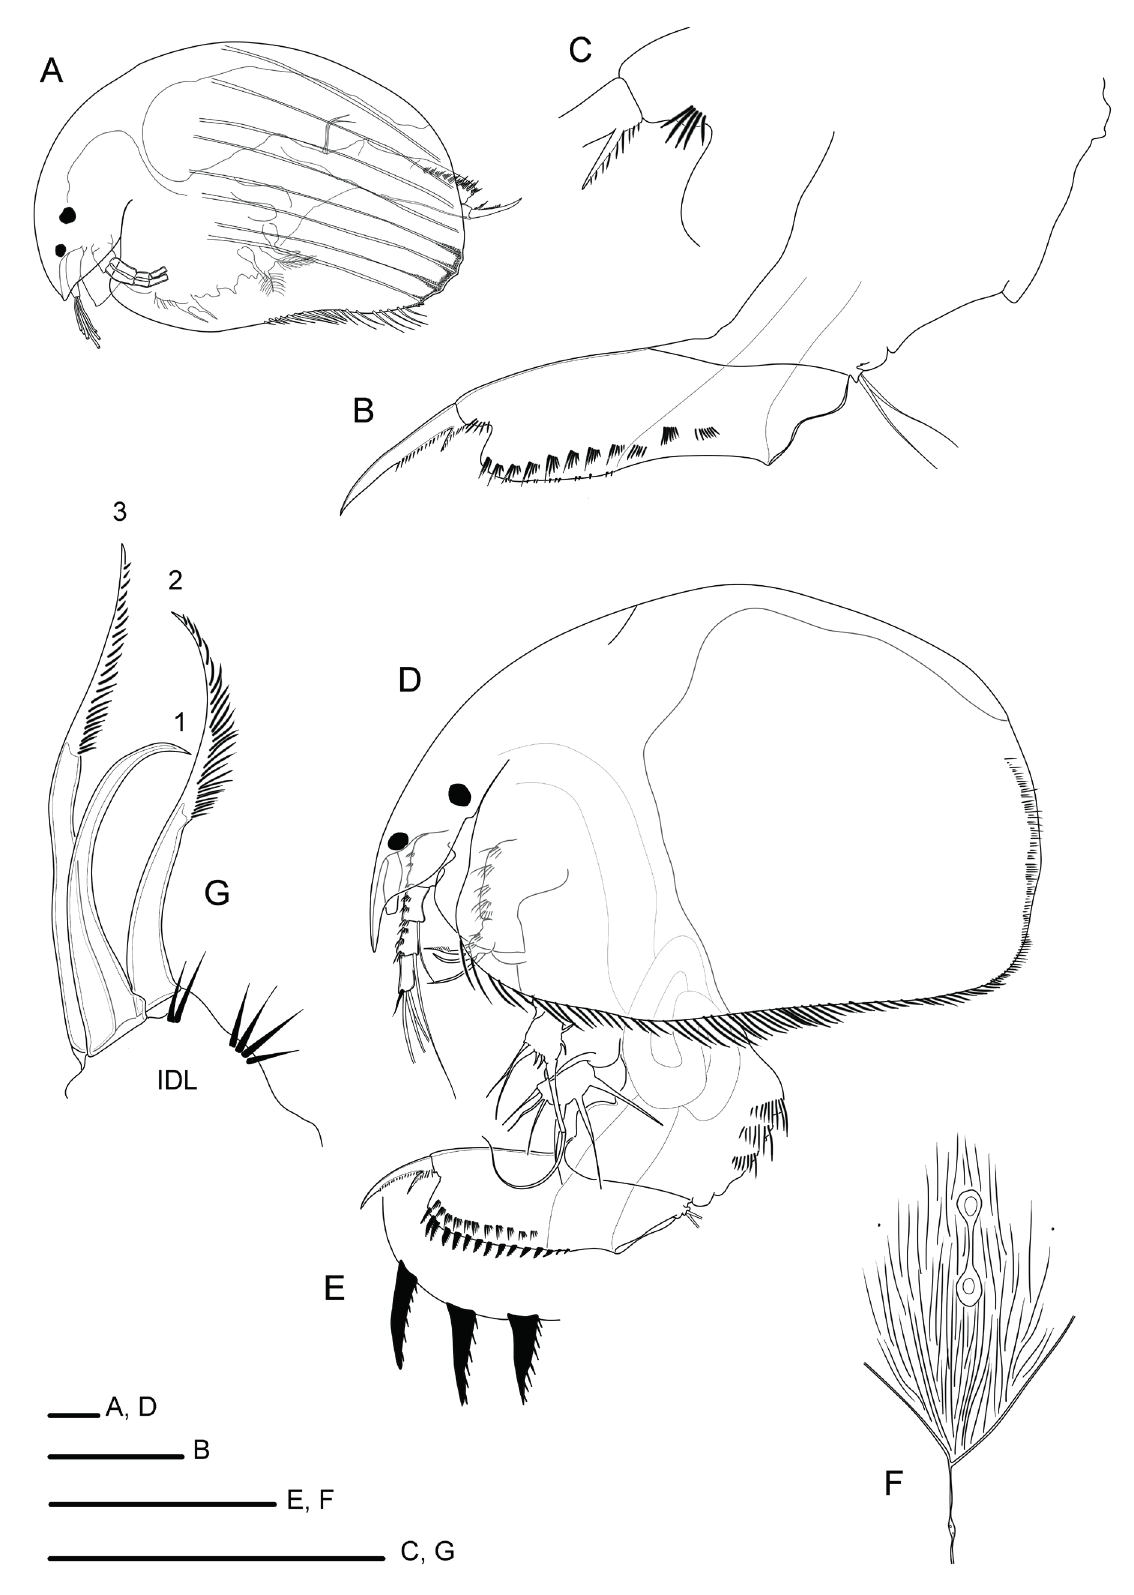
Figure 2. Parthenogenetic females from Lake Paranoá: A, Acroperus tubinamba ; B, idem , postabdomen; C, idem , base of postabdominal claw; D, Alona ossiani ; E, idem , marginal denticles on the postabdomen; F, idem , main head pores; G, idem , Inner Distal Lobe (IDL) of the first limb. Scale bars = 50